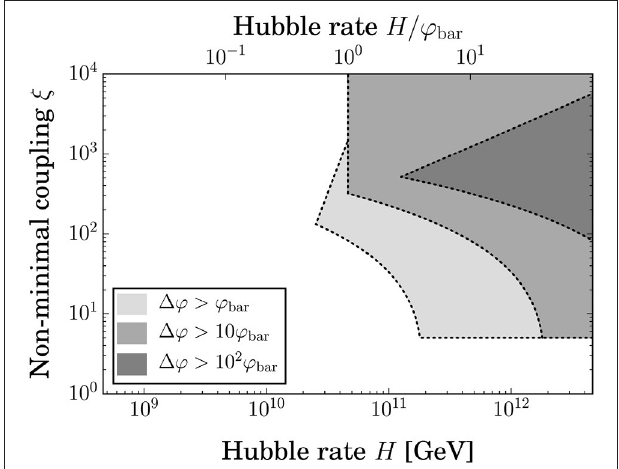
FIGURE 9 | Regions where the Higgs fluctuations 1ϕ generated after inflation by a single inflaton oscillation are greater than the barrier height ϕ bar for a model with no direct couplings between the Higgs and the inflaton. The Higgs fluctuations are given by Equation (5.53) while taking into account backreaction effects from self-interactions and gravity. The amplitude of the inflaton at the end of inflation is assumed to satisfy φ 0 0.3 M P and we have = used the value ϕ bar 4.64 10 10 GeV from section 2.3. Regions below ξ 5 = × = have been cut according to the bound obtained in Figueroa et al.